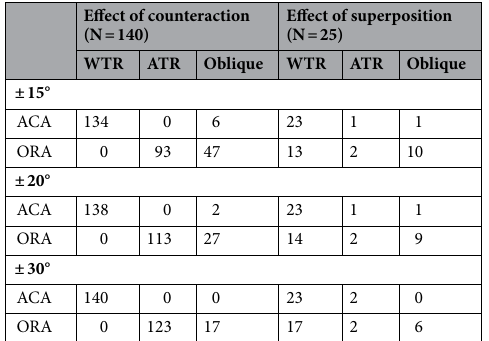
Table 2. The influence of ORA on ACA with different classification standards.